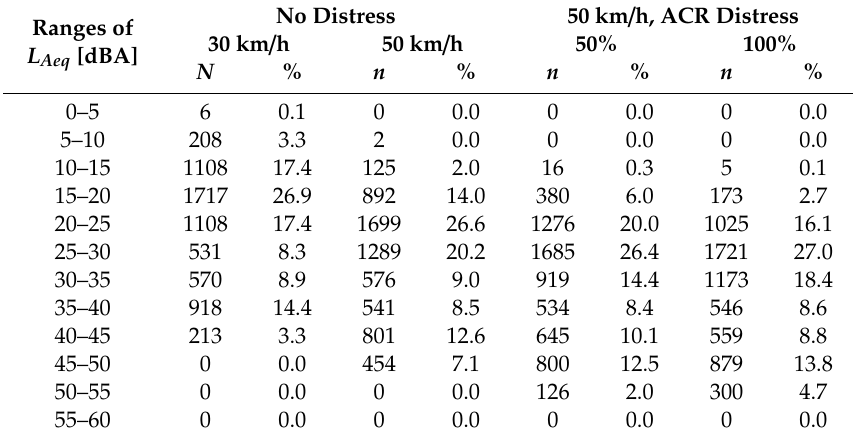
Table 8. Population exposed to noise, AC pavement— L Aeq ranges.